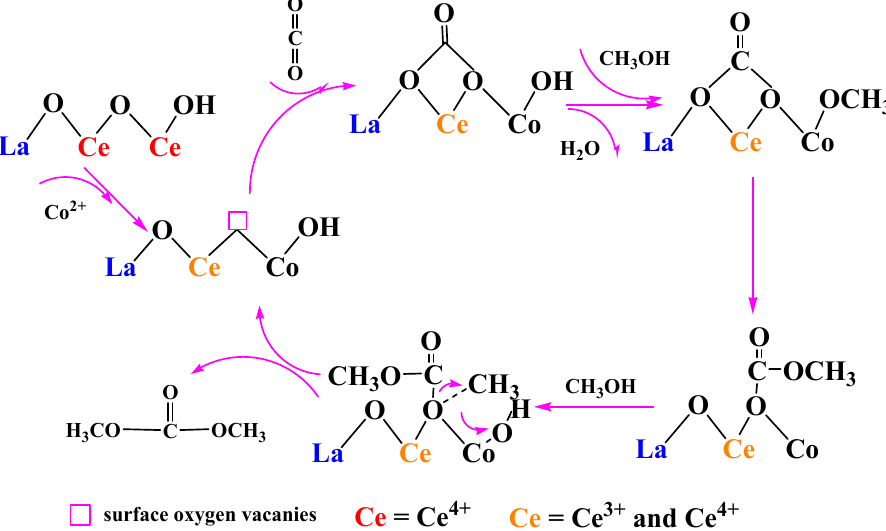
Figure 7. Proposed mechanism of DMC formation from CO 2 and CH 3 OH at the surface oxygen vacancies over Ce-La-M catalysts.